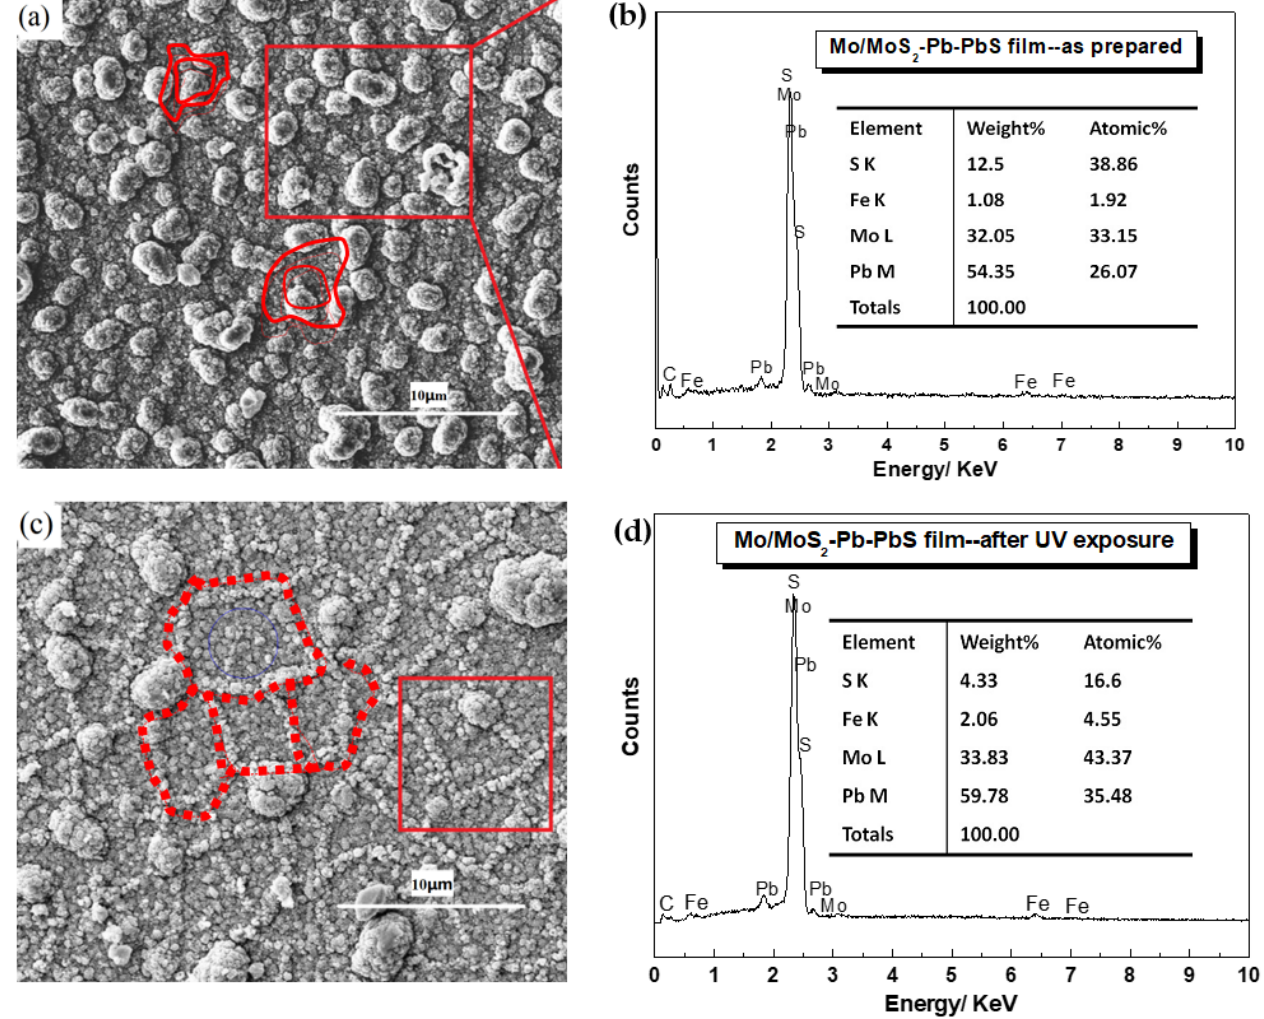
Figure 2. Morphology and composition of Mo/MoS 2 -Pb-PbS composite films before and after UV radiation. ( a , b ) SEM and composition of Mo/MoS 2 -Pb-PbS composite films without UV radiation, ( c , d ) SEM and composition of Mo/MoS 2 -Pb-PbS composite films after 40 h UV radiation.